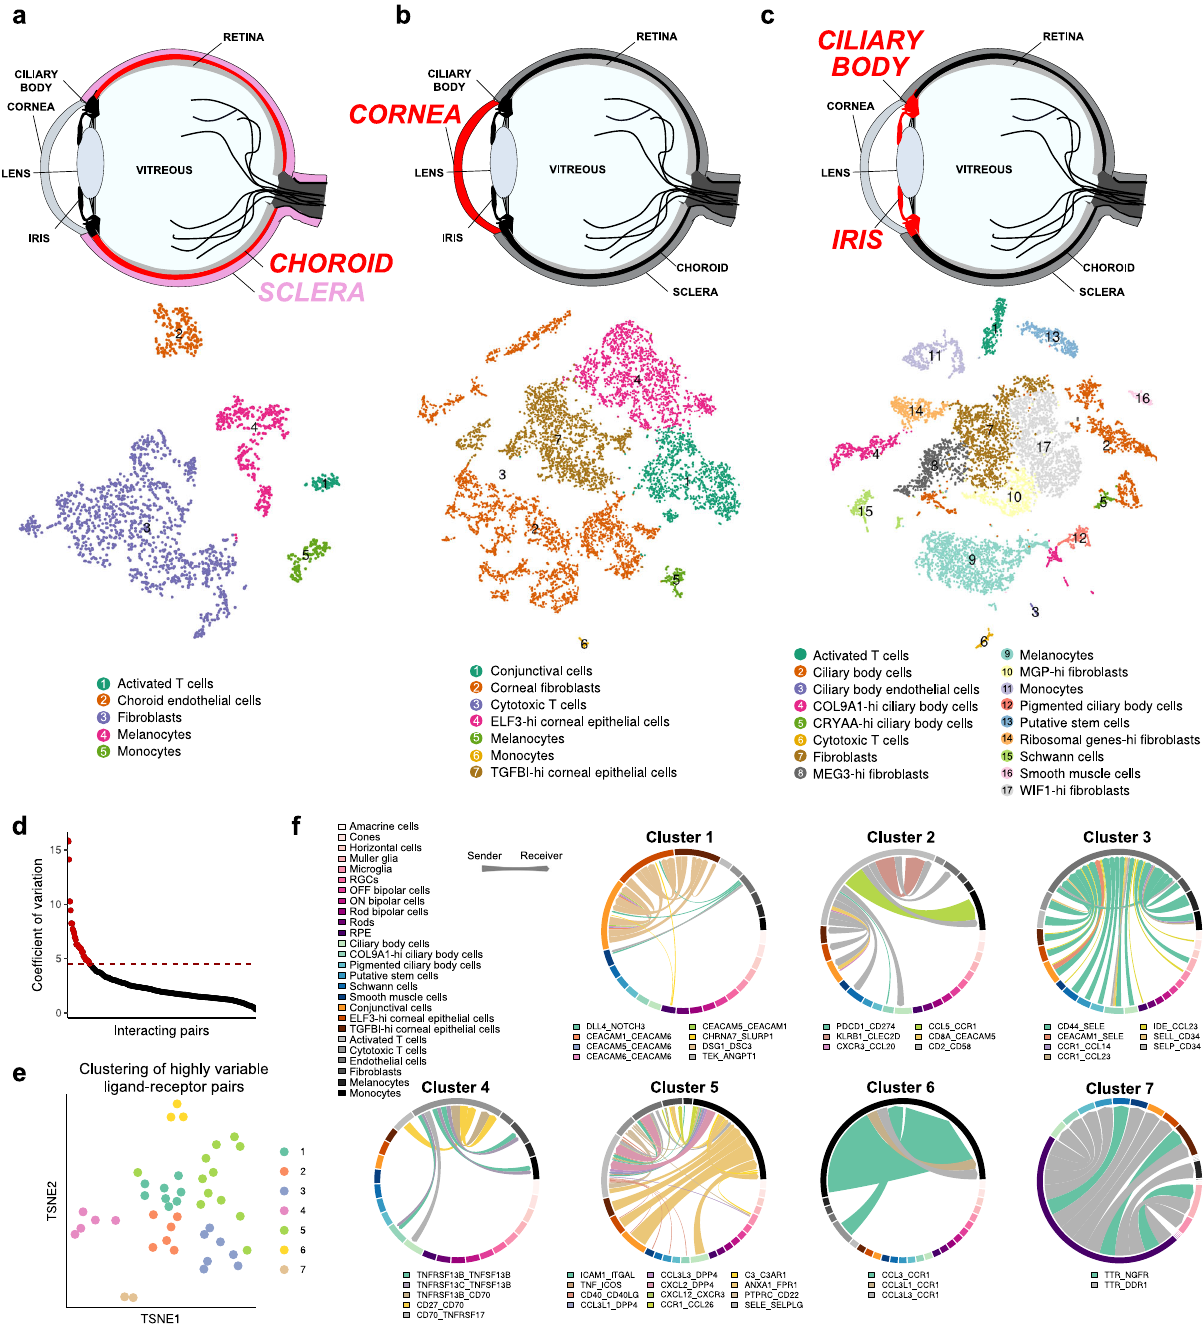
Fig. 3 Single-cell transcriptome atlas from non-retina cells in the human eye. a tSNE plot visualisation of cells obtained from scleral and choroid layers of the eye. Five transcriptionally distinct clusters were observed. b tSNE plot visualisation of cells obtained from the cornea of the eye. Seven transcriptionally distinct clusters were observed. c tSNE plot visualisation of cells obtained from iris pigmented epithelium, iris muscle, and stromal region of iris. Seventeen transcriptionally distinct clusters were observed in the iris region of the eye. d Selecting highly variable interacting pairs that exhibited high cell type-to-cell type variation in the dataset. e Hierarchical clustering of similar cell – cell signalling probability scores and visualised on a tSNE plot. f Global cell – cell interaction map across cell type of the eye. Edge weights represent the probability of signalling between cell